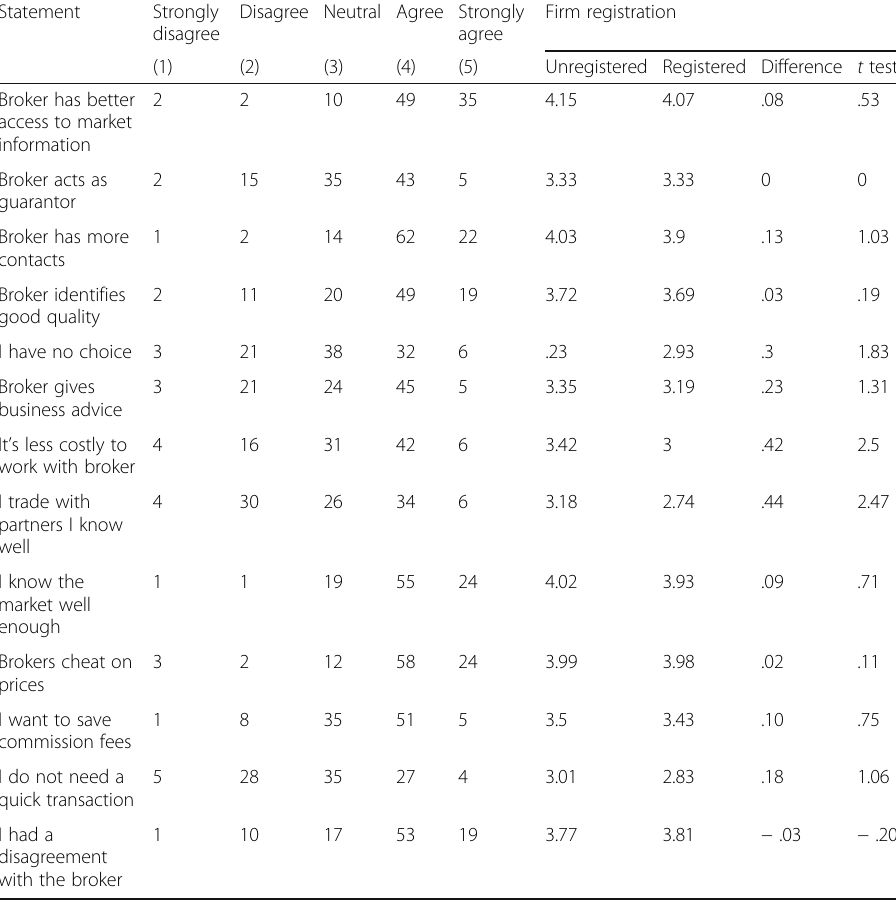
Table 5 Perceptions of traders ’ interactions with brokers and other traders. Percentages are reported in the Likert Scale and t test is used to assess differences in perceptions between firms that were registered and those that were